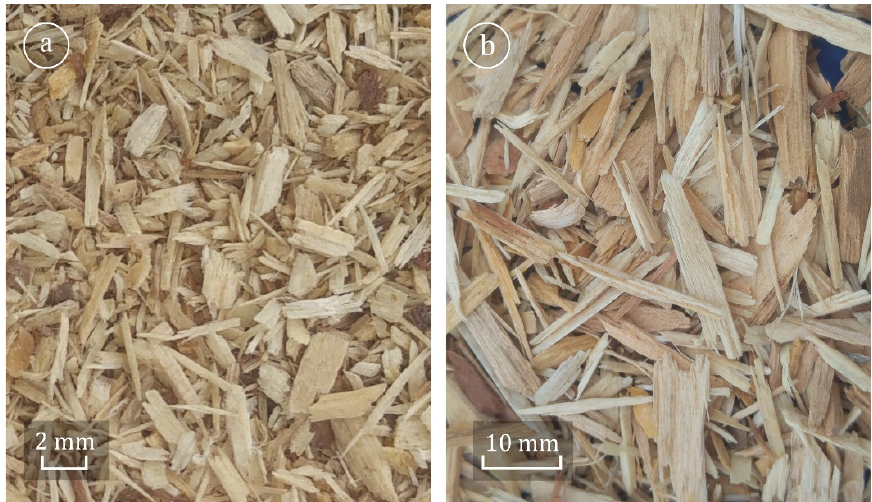
Figure 1. Images of wood particles: ( a ) microparticles (MP), ( b ) particles of the core layer particleboards (PCL).